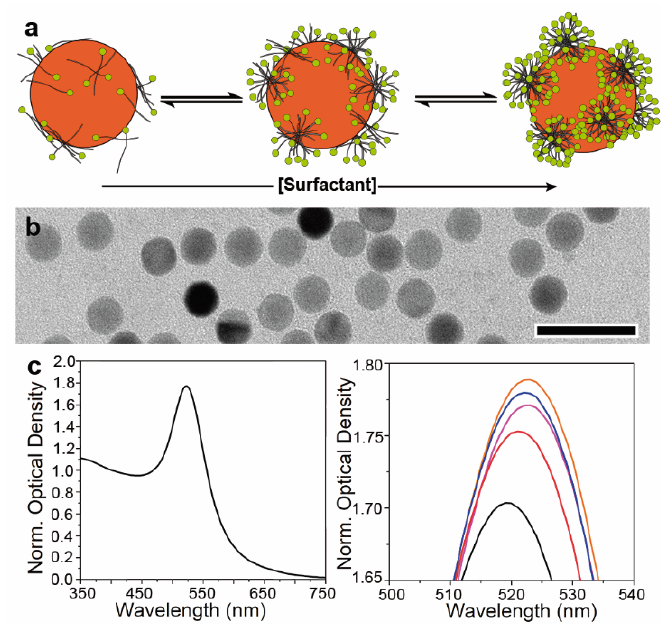
Figure 2. Tuning CTAB adsorption on AuNC surface. ( a ) Schematic view of the changes in the amount of CTAB adsorbed on the AuNC surface as a function of its concentration in solution. At concentrations below the CMC (ca. 1 mM for CTAB), molecules or small surfactant aggregates are expected to be adsorbed, while above the CMC, micellar structures are expected to be found on the metal surface. ( b ) TEM image of 9 nm AuNCs used to investigate the effect of surfactant adsorption on its sedimentation behaviour. Scale bar: 25 nm ( c ) Normalized UV-Vis spectra of 9 nm AuNCs (left) and the impact of increasing concentration of CTAB (right) on the position and intensity of the plasmonic band: 10 µ M (black), 125 µ M (red), 500 µ M (magenta), 1000 µ M (blue), and 3000 µ M (orange). Normalization is performed at 400 nm, where the AuNC absorption is less sensitive to the plasmonic property changes